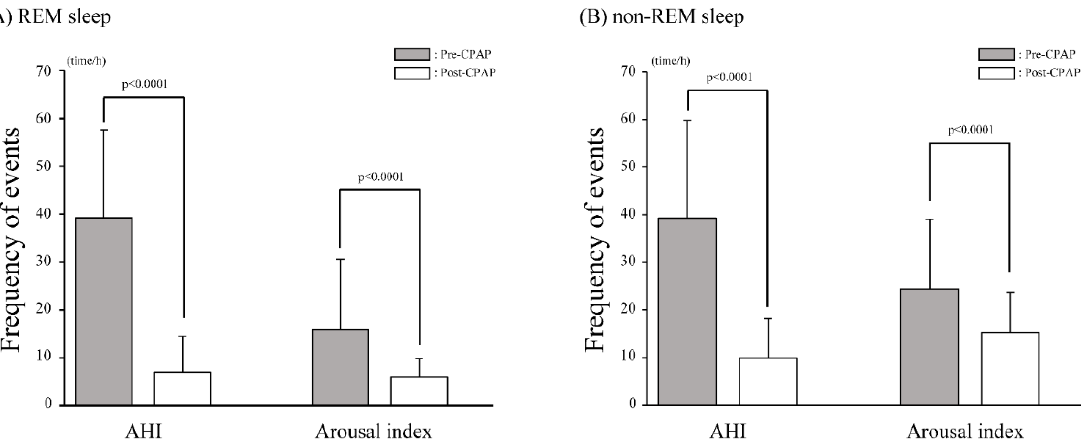
Figure 1. A comparison of sleep-related parameters pre- and post-CPAP. ( A ) REM sleep. ( B ) Non- REM sleep. Gray and white bars indicate the values pre- and post-CPAP, respectively. Values are presented as means ± SDs; error bars represent SD. AHI, apnea-hypopnea index; CPAP, continuous positive airway pressure; SD, standard deviation.